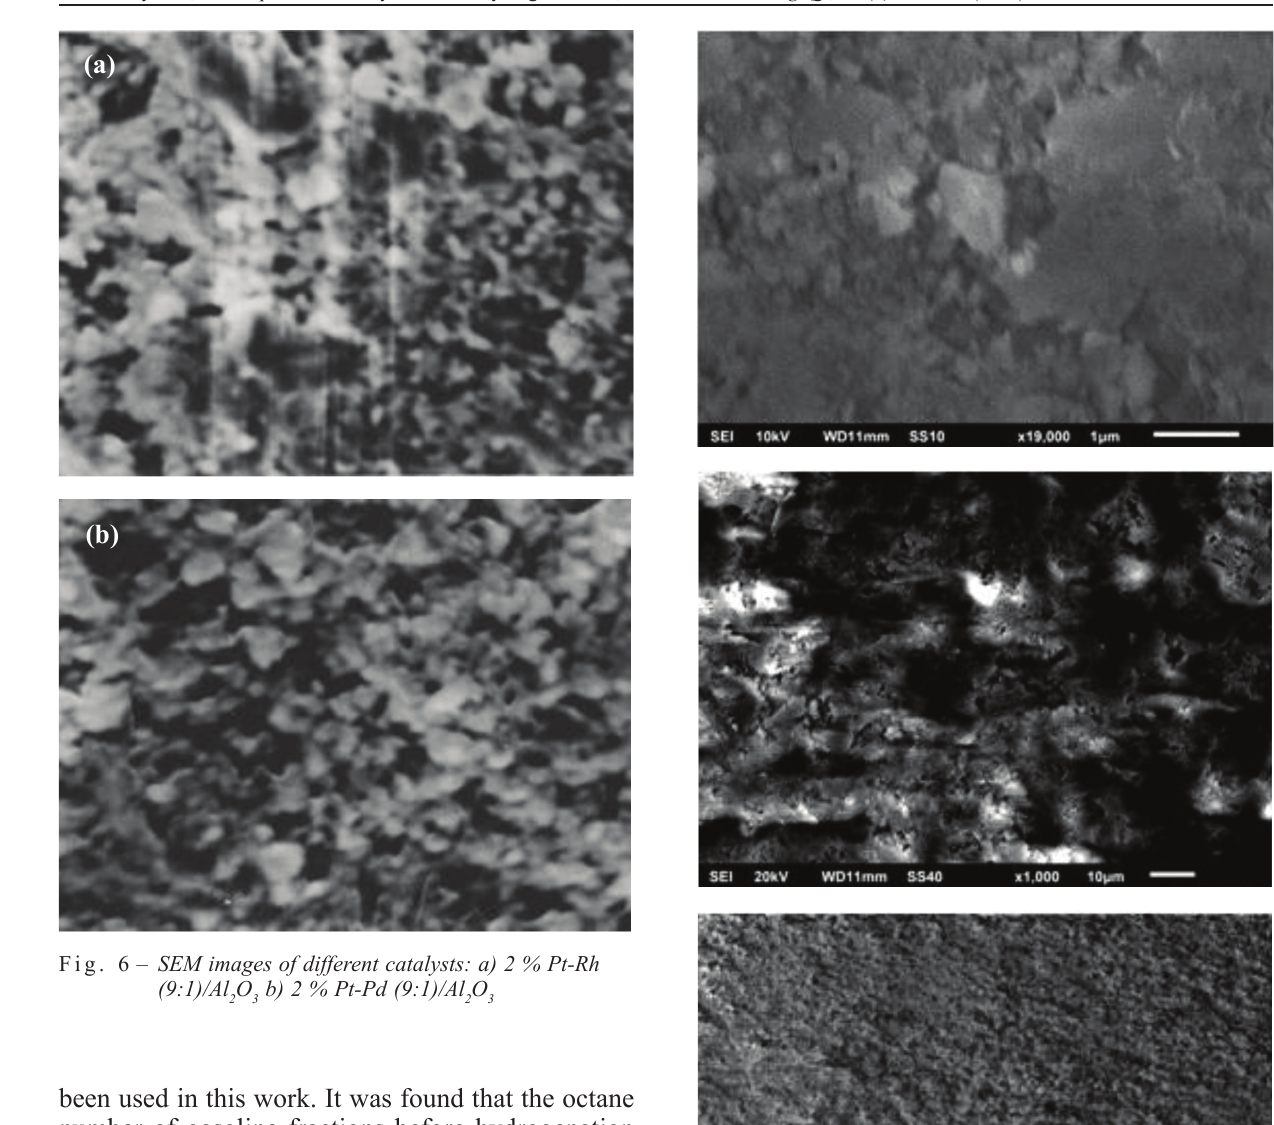
O at different 2 3